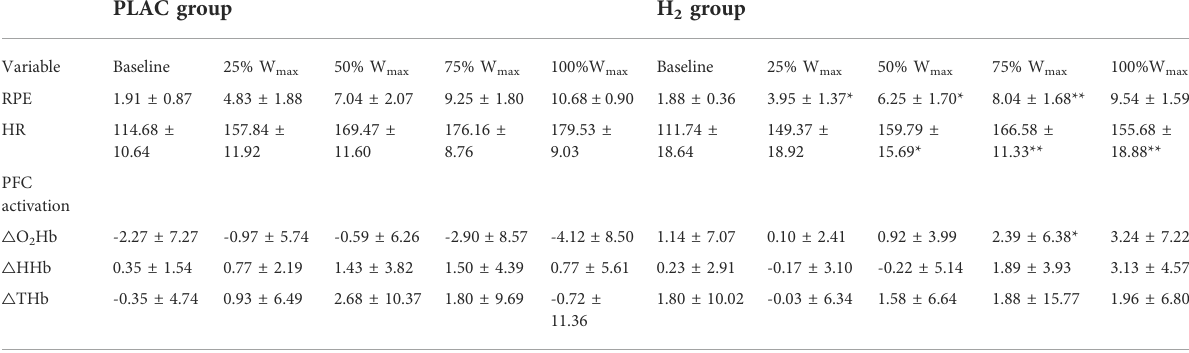
TABLE 3 RPE, HR and PFC activation during the cycling exercise in the PLAC and H 2 groups (mean ± SD). PLAC group H 2 group